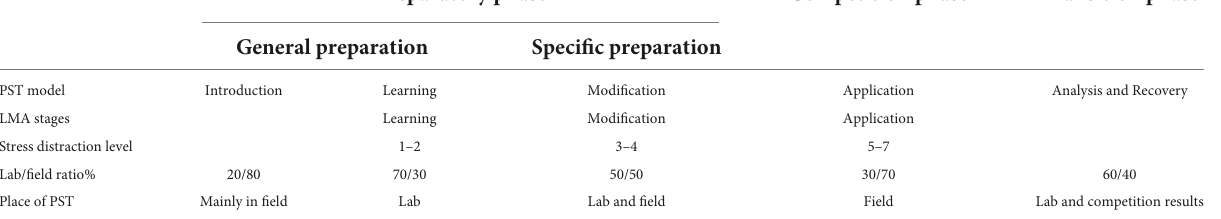
TABLE 1 Main intervention programs in the psychological skills training (PST)